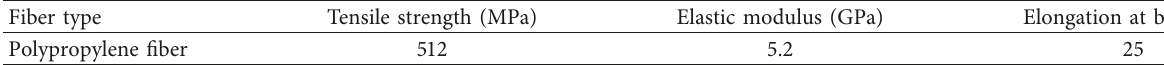
Figure 1: Testing equipment and materials: (a) polypropylene fibers, (b) direct shear test apparatus, and (c) unconfined compression test apparatus. Table 2: Behavior parameters of fiber.